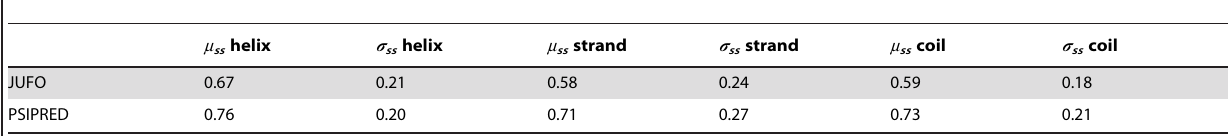
Table 1. Mean and standard deviation of predicted